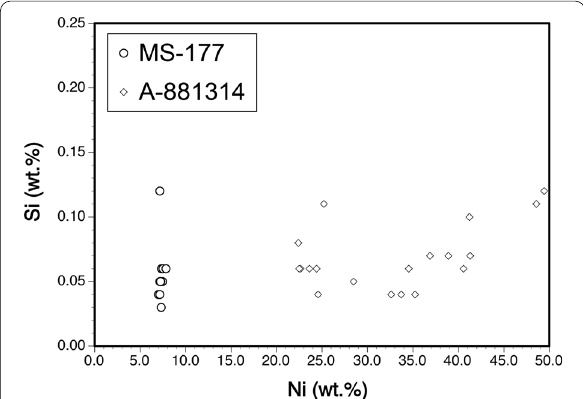
Fig. 4 Compositions of schreibersite in MS-177 and A-881314 on Ni versus Si plot